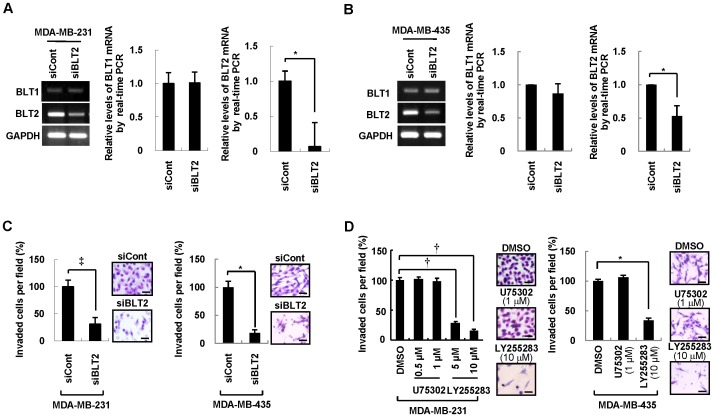
BLT2 is required for the invasiveness of MDA-MB-231 and MDA-MB-435 breast cancer cells.(A and B) MDA-MB-231 (A) and MDA-MB-435 (B) cells were transfected with BLT2 (siBLT2) or control (siCont) siRNAs for 48 h in medium supplemented with 0.5% FBS, after which the amounts of BLT1 and BLT2 mRNAs were determined by semiquantitative RT-PCR (left panel) and quantitative real-time PCR (center and right panels) analysis. Data are representative of five independent experiments. (C) Cells treated as in (A) and (B) were assayed for invasiveness. Representative invading cells stained with H&E are shown, and quantitative data are expressed relative to the value for cells transfected with the control siRNA. Scale bars, 50 µm. (D) MDA-MB-231 and MDA-MB-435 cells were incubated with U75302 (0.5 or 1 µM), LY255283 (5 or 10 µM), or DMSO vehicle for 30 min and were then assayed for invasiveness in the continued presence of the corresponding test agent. Scale bars, 50 µm. All quantitative data are means±SD from five independent experiments. *P<0.05, †P<0.01, ‡P<0.005.